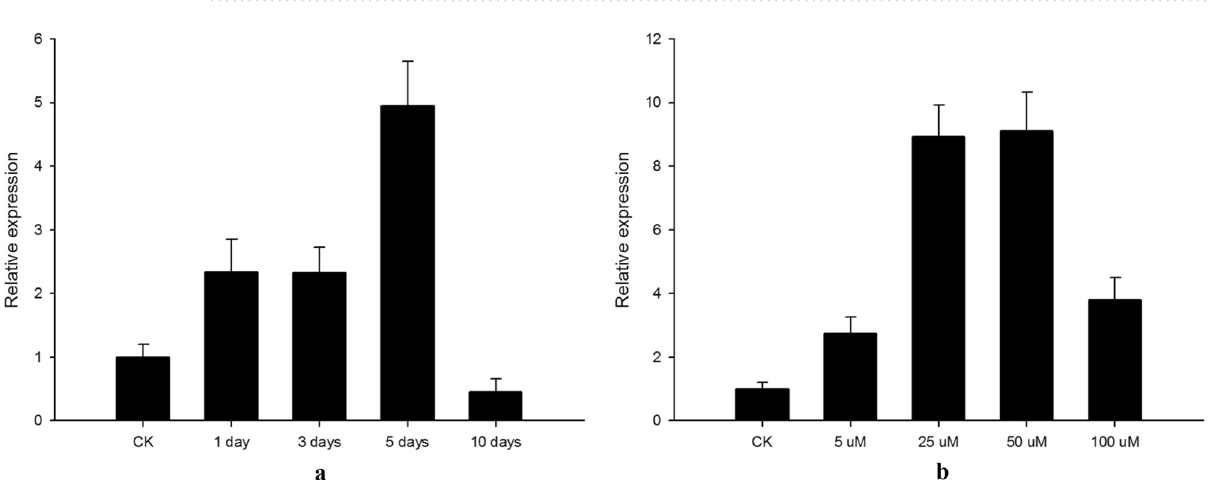
Figure 3. Transcriptional levels of DTA gene on the first axillary buds applied with different concentrations and time duration. ( a ) Changes in the expression level of the Diphtheria toxin A gene at 10 days after 50 µM dexamethasone induction; b: Changes in the expression level of the Diphtheria toxin A gene 5 days after induction with different dexamethasone